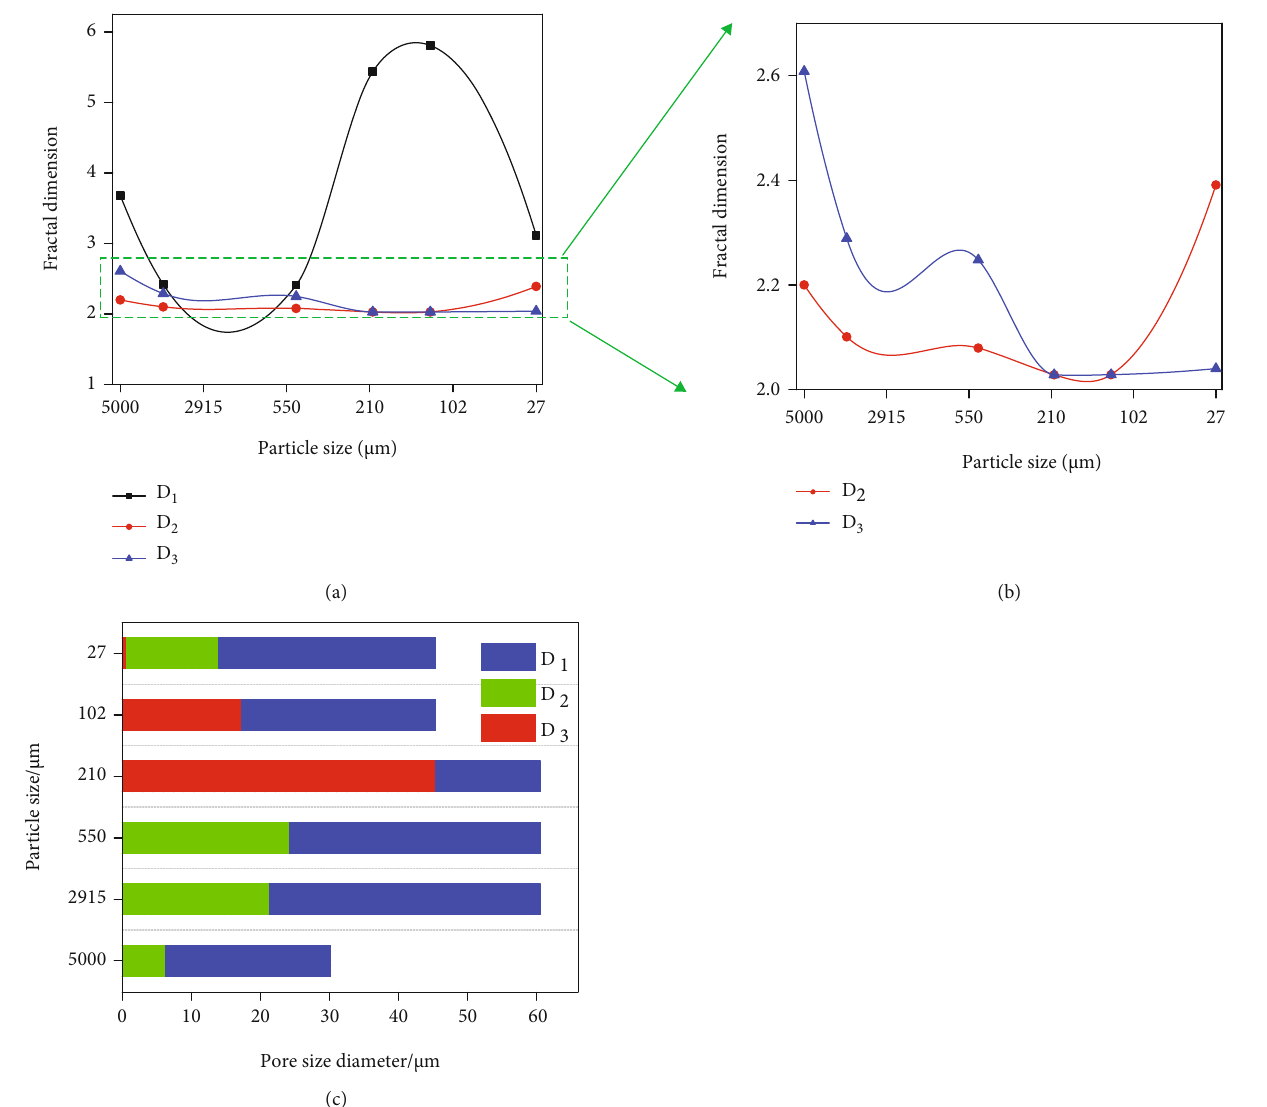
Figure 9: E ff ect of particle size on fractal dimensions of shale pore structure. (a) Fractal dimensions d di ff erent particle sizes. (b) Fractal dimensions d ranges of fractal dimensions d